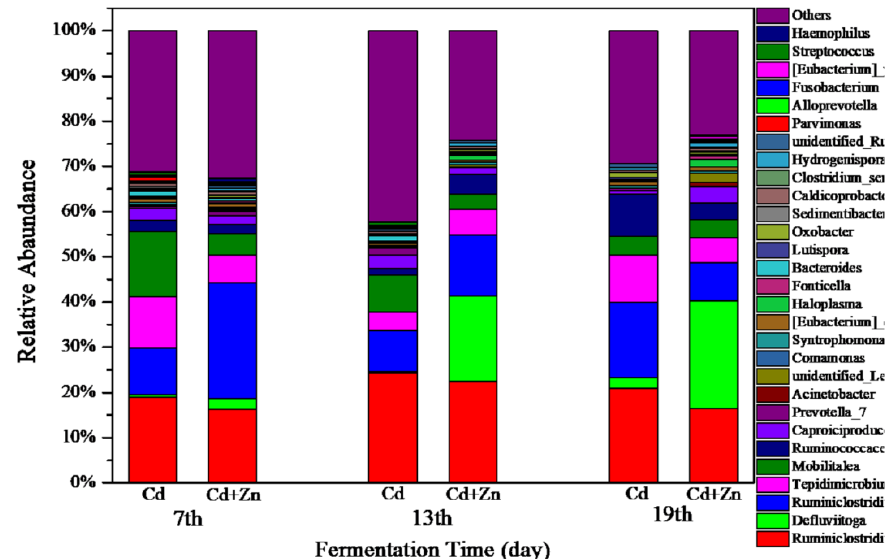
Figure 8. Impact of Cd and Cd+Zn addition on Structure of bacterial communities during fermentation.